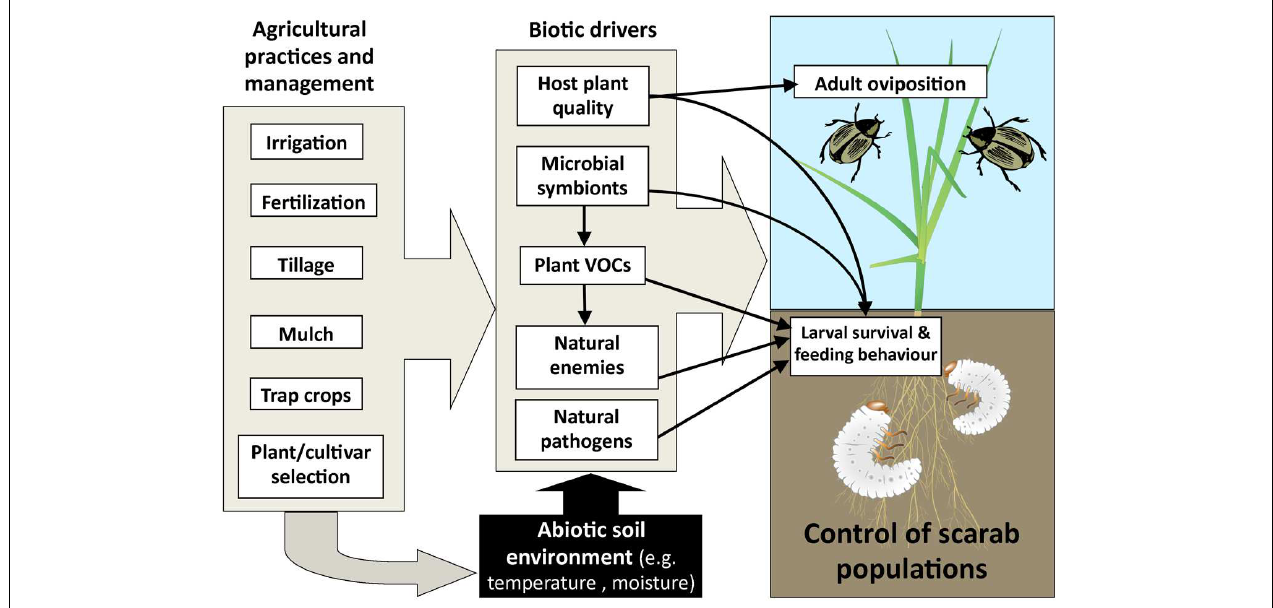
FIGURE 5 | Diagram of agricultural practices and management factors that impact on plant and soil factors (abiotic and biotic), which in turn can influence oviposition by adults together with larval survival and feeding behavior. Arrows indicate key linkages between interacting